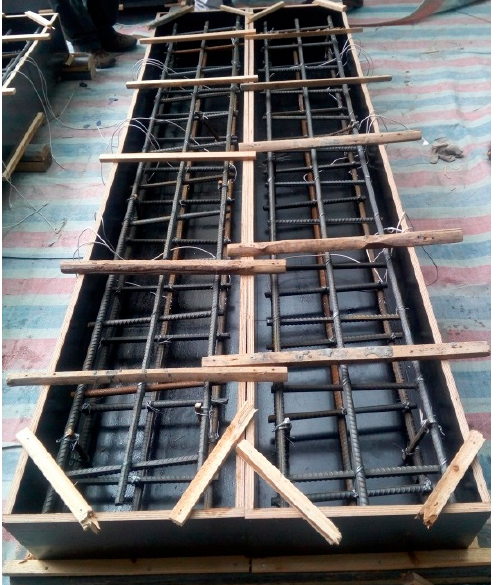
Figure 4. Reinforcement layout in frame work before casting.